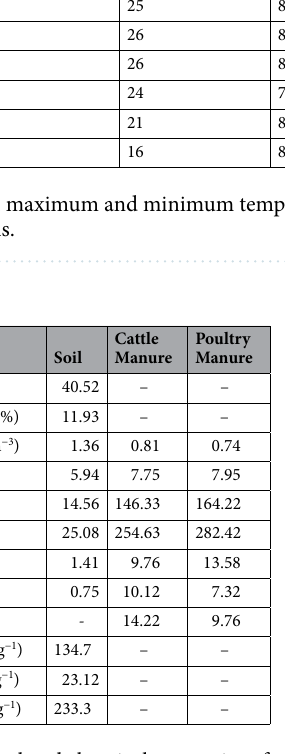
Table 5. Physical and chemical properties of soil and manure before the experimentation. SOC soil organic carbon, SOM soil organic matter, N nitrogen, P phosphorous, K potassium, C: N carbon to nitrogen ratio.